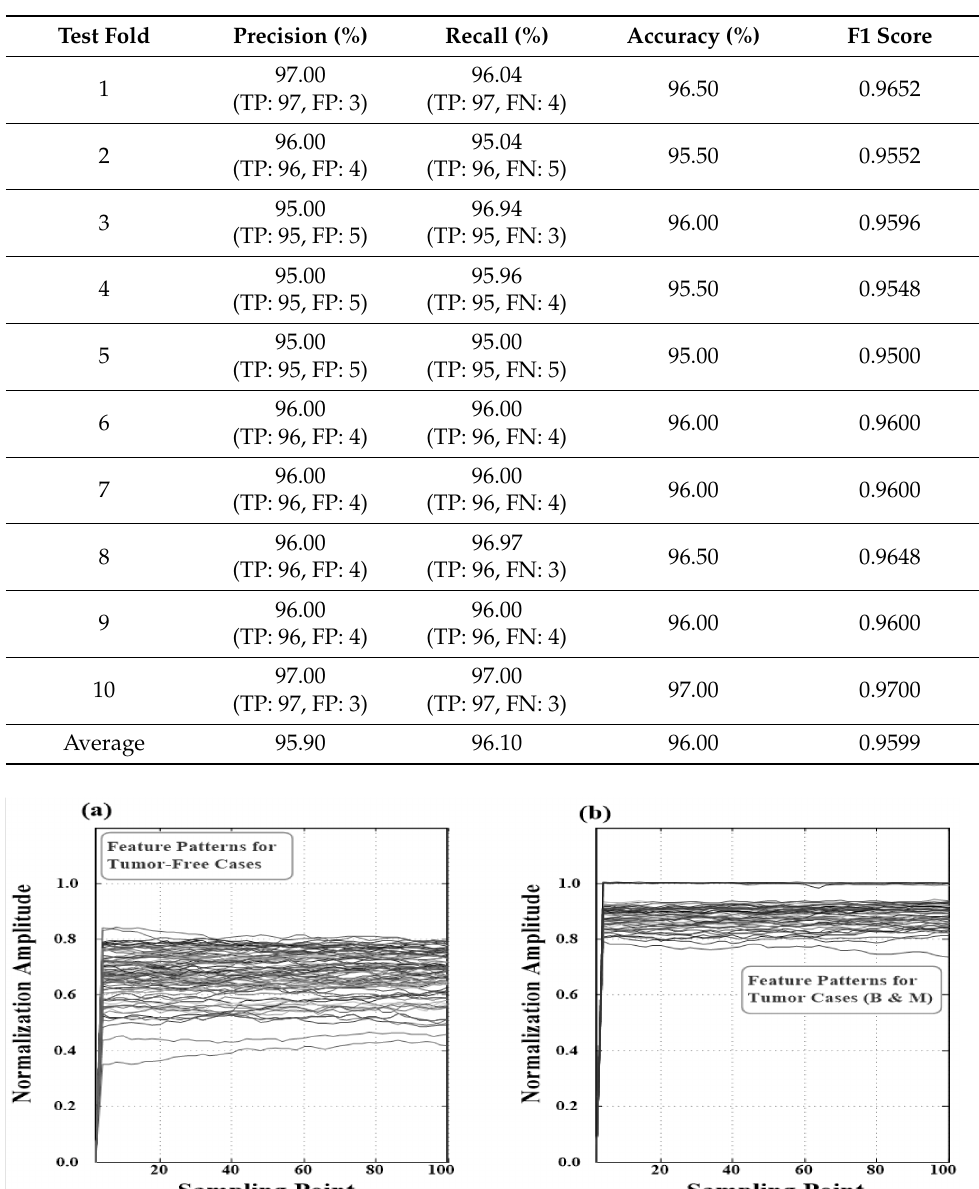
Table 3. Experimental results for 2D fractional-order CNN-based classifier with the 10-fold cross- validation test.